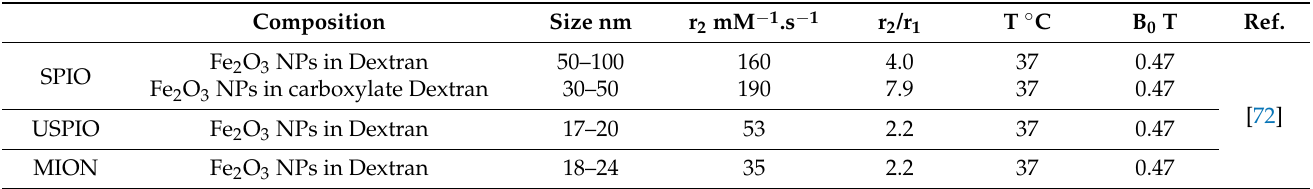
Table 3. Main characteristics of iron oxide-based negative CAs. Note, the reported r 2 and r 2 /r 1 values were expressed per mM of iron atoms.